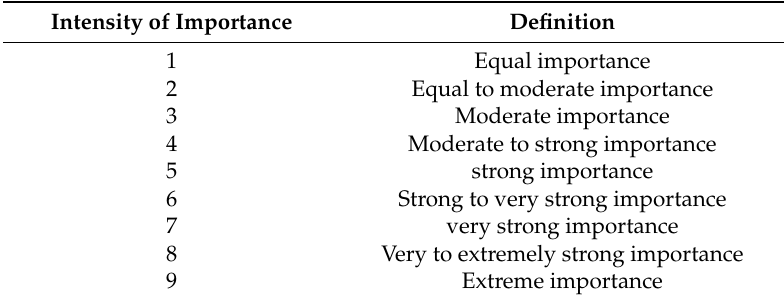
Table 6. Saaty’s scale for weight assignment